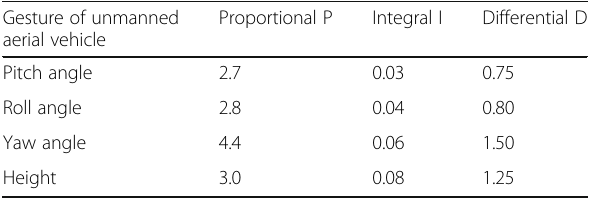
Table 1 Proportional-integral-derivative